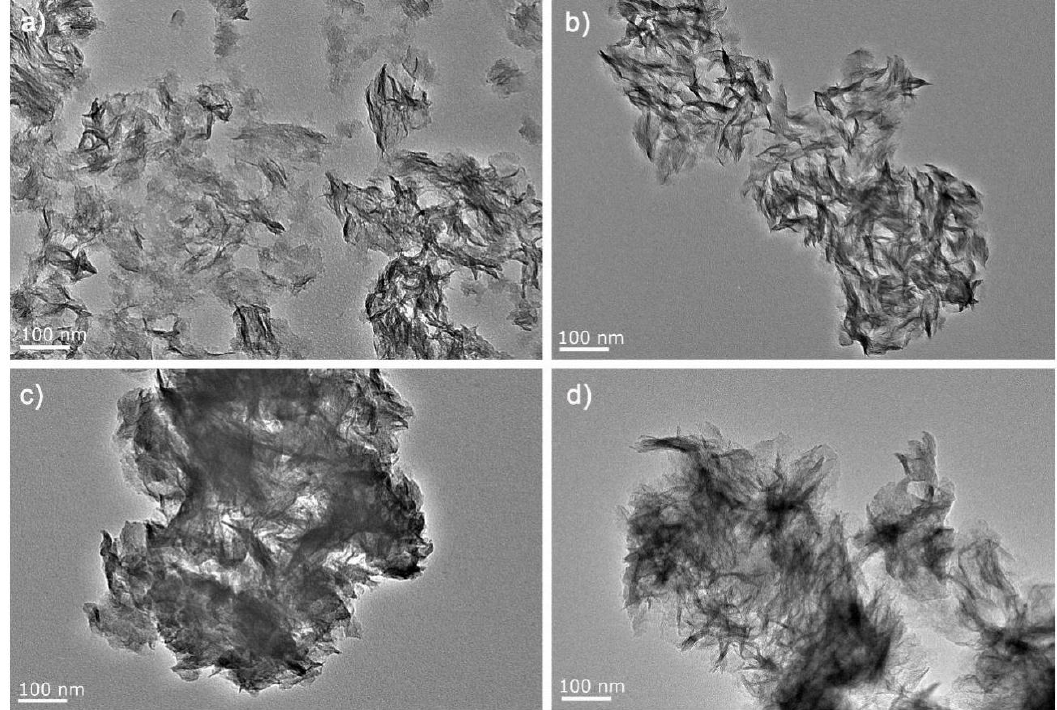
Figure 1. Representative transmission electron microscopy (TEM) images of ( a ) pure TiO 2 ; ( b ) 10% F-TiO 2 ; ( c ) 10% I-TiO 2 and ( d ) 10% S-TiO 2 .